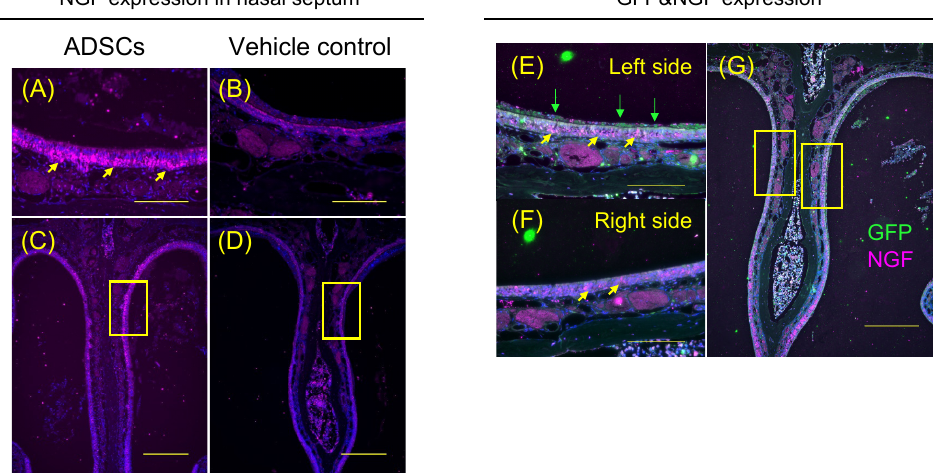
Figure 5. Expression of nerve growth factor by ADSCs in vivo. ( A – D ) Representative images of immunohistochemical staining of nerve growth factor (NGF) in the five mice after nasal administration of ADSCs ( A , C ) or in the mice after nasal administration of PBS ( B , D ). Arrows indicate NGF ( A ). ( E – G ) Immunohistochemical analysis of ADSCs by GFP signal (Green) and NGF expression (Purple) in the nasal cavity and epithelium of ADSC-treated mice. Images are representative of five mice treated with ADSCs and of five mice treated with PBS. Yellow arrows indicate NGF and green arrows indicate GFP ( E ). Arrows indicate NGF ( F ). Bars = 100 µ m ( A , B , E , F ) and 250 µ m ( C , D , G